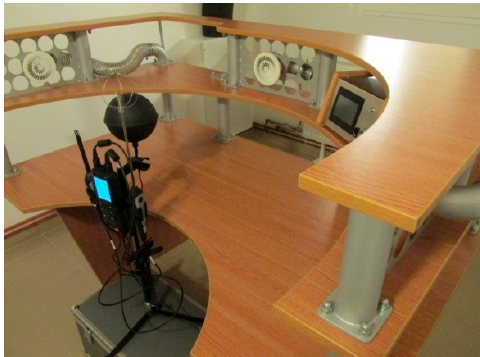
Figure 1. ALTAIR PV system.